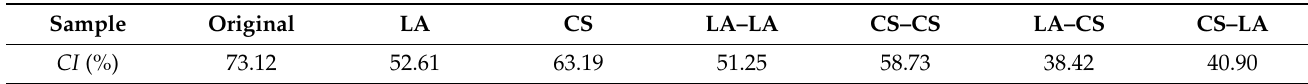
Table 2. The CI values of pre-mercerized and post-mercerized cotton in LA and